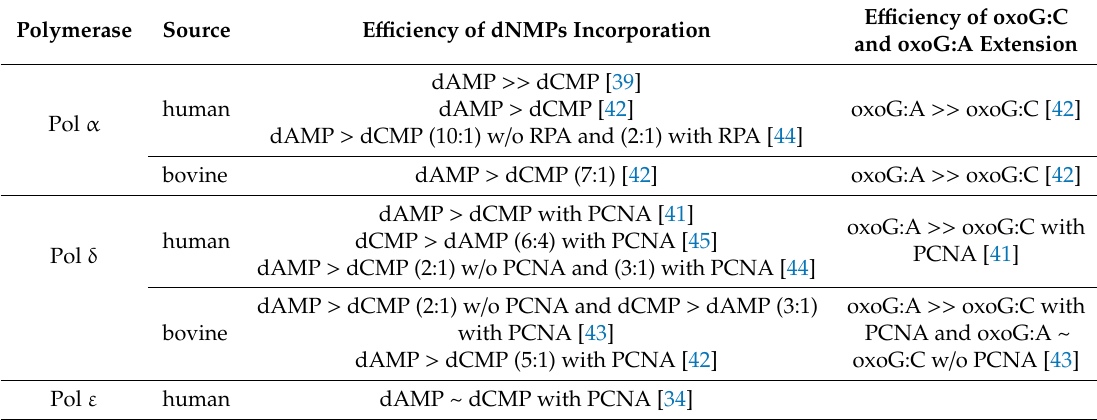
Table 1. Activities of eukaryotic high-fidelity DNA polymerases opposite oxoG in